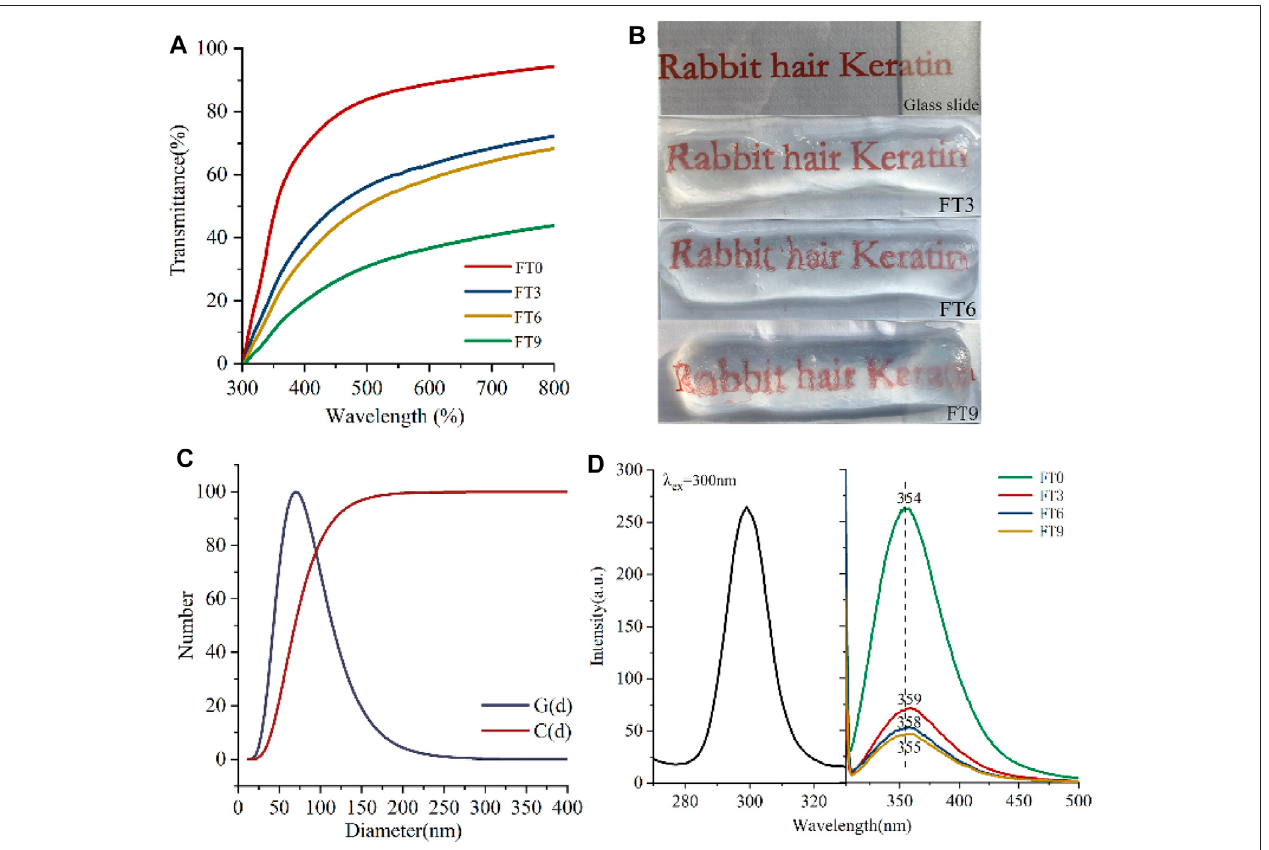
FIGURE4|(A) OpticaltransmittancesofkeratinhydrogelatvariedFTcycles, (B) photographsoftheglassandkeratinhydrogel, (C) DLSofkeratinsolution,and (D) room temperature excitation and emission spectra.